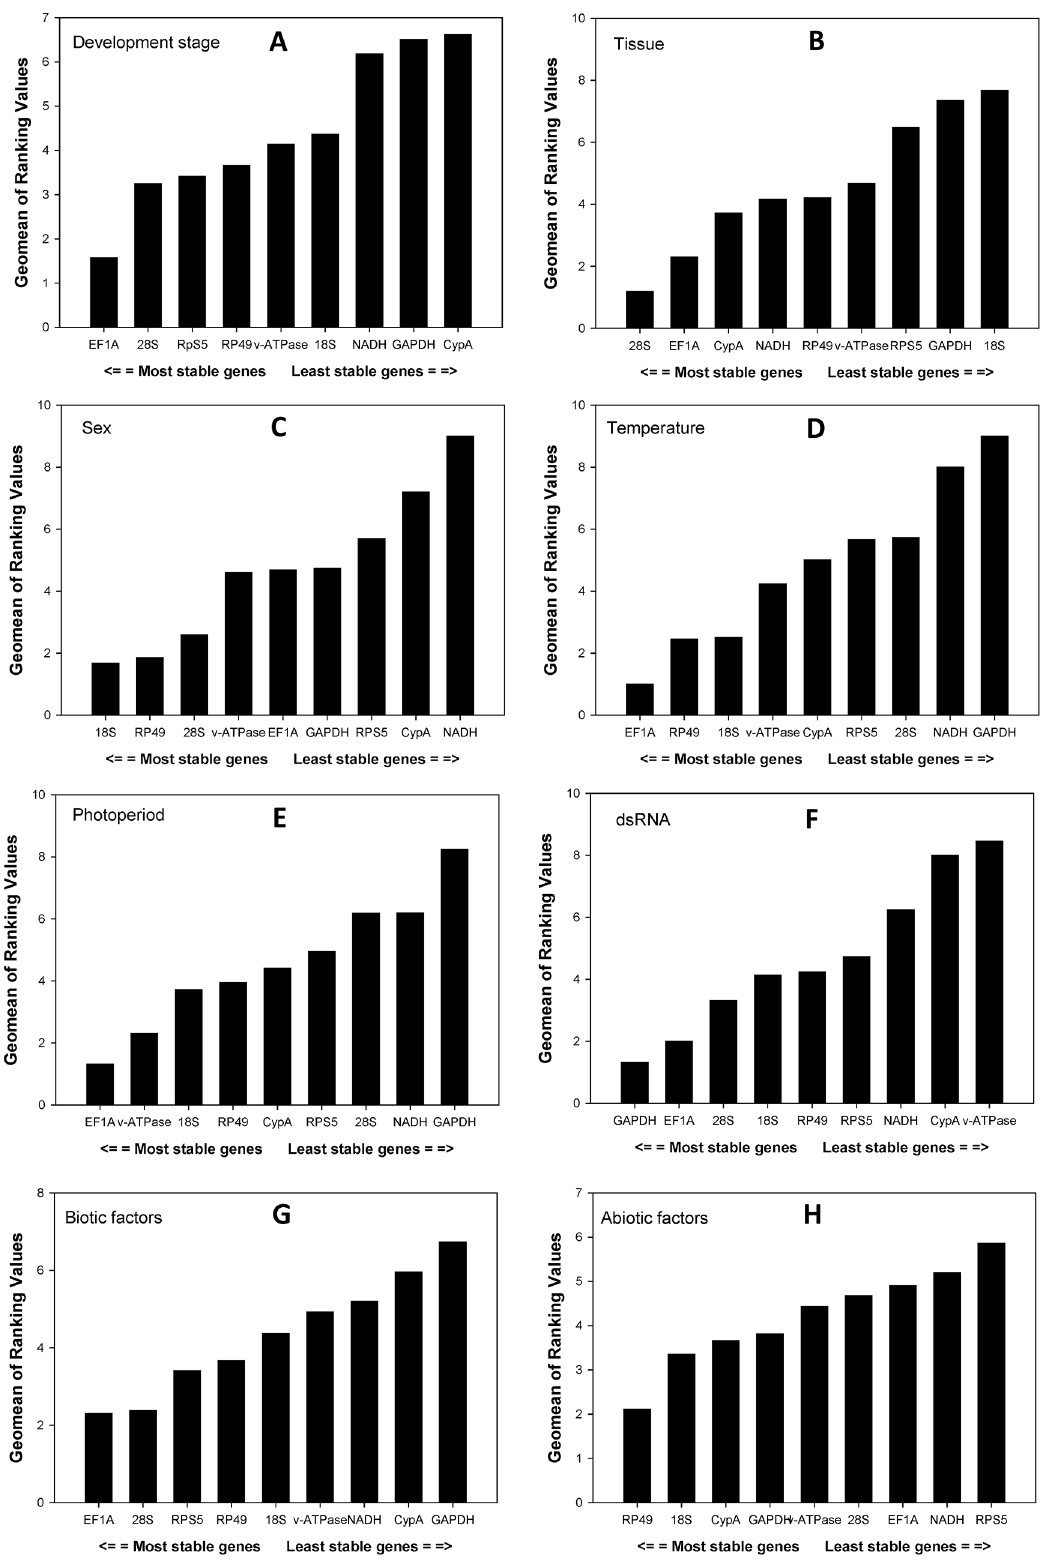
Fig 2. Stability of candidate reference genes expression under different treatment by RefFinder . A lower Geomean value indicates more stable expression. doi:10.1371/journal.pone.0129482.g002 PLOS ONE | DOI:10.1371/journal.pone.0129482 June 1,